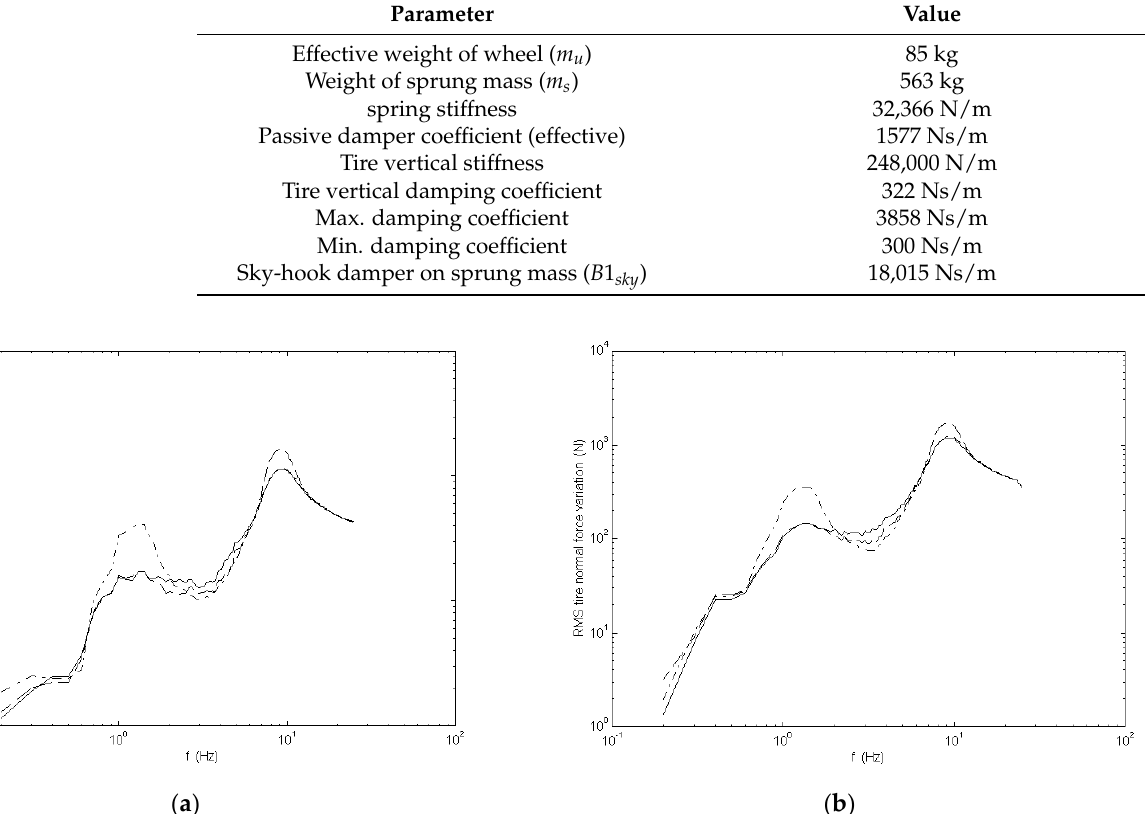
Figure 5. RMS of the tire normal force variation. ( a ) smooth road; ( b ) rough road.